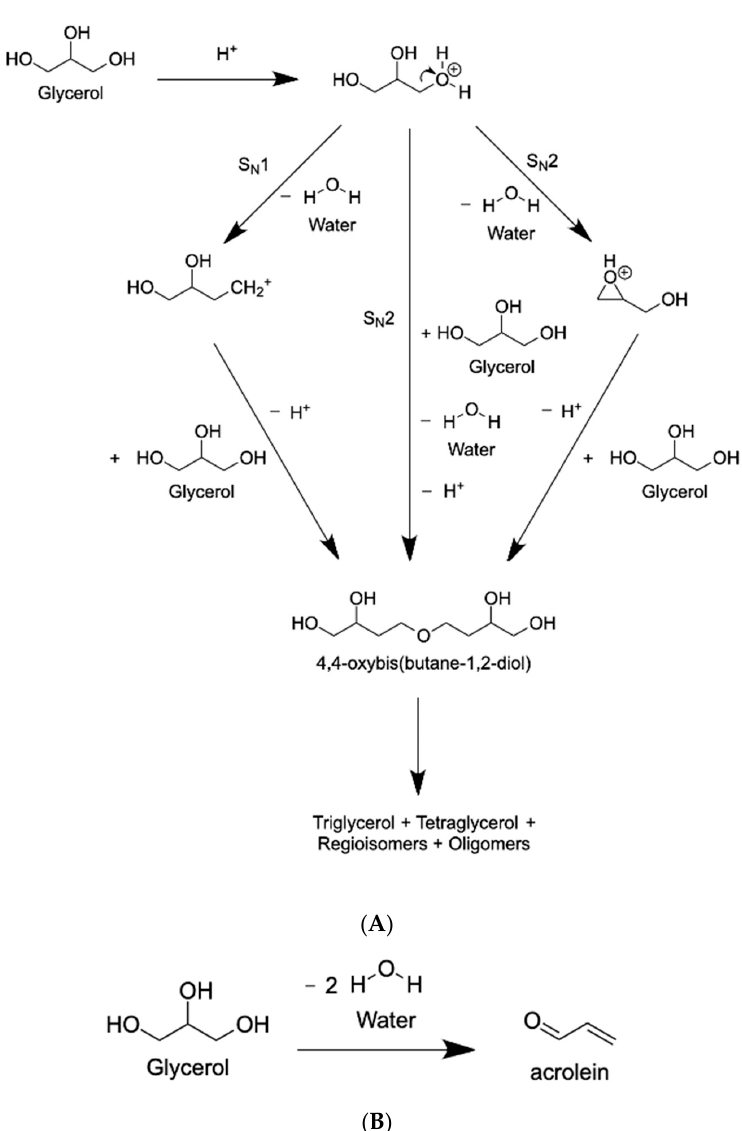
Figure 18. ( A ) Reaction mechanism for solvent-free glycerol etherification with acidic catalysts [112]; ( B ) Undesired side reaction leading to the formation of acrolein [112]. A 100% glycerol conversion was obtained in the presence of a 3 wt% H 2 SO 4 catalyst in 4 h on stream (TOS) at a temperature of 220 °C along with 24% and 31% di- and triglyc- erol selectivity, respectively [129]. Despite being more rapid, the acid-catalyzed etherifi- cation reaction is less selective because of the greater level of oligomerization that involves secondary compounds formed through dehydration and oxidation reactions. Tetra-, penta- and hexa-glycerol are likely to be produced in this reaction as dehydrated deriva- tives of glycerol such as alkenes, aldehydes, and ketones [7]. The production of acrolein from glycerol has been observed with an acid catalyst in the liquid phase such as sulfuric or phosphoric acid derivatives or in the gas phase with supported or non-supported tung- sten and zeolite [112]. Acrolein, which is a large molecular weight molecule produced by an acid catalyst under the temperature between 250 °C and 350 °C when etherifying glyc- erol, could devour existing glycerol and reduce the selectivity of the desired products [130]. While homogeneous base catalysts showed higher linear glycerol selectivity,